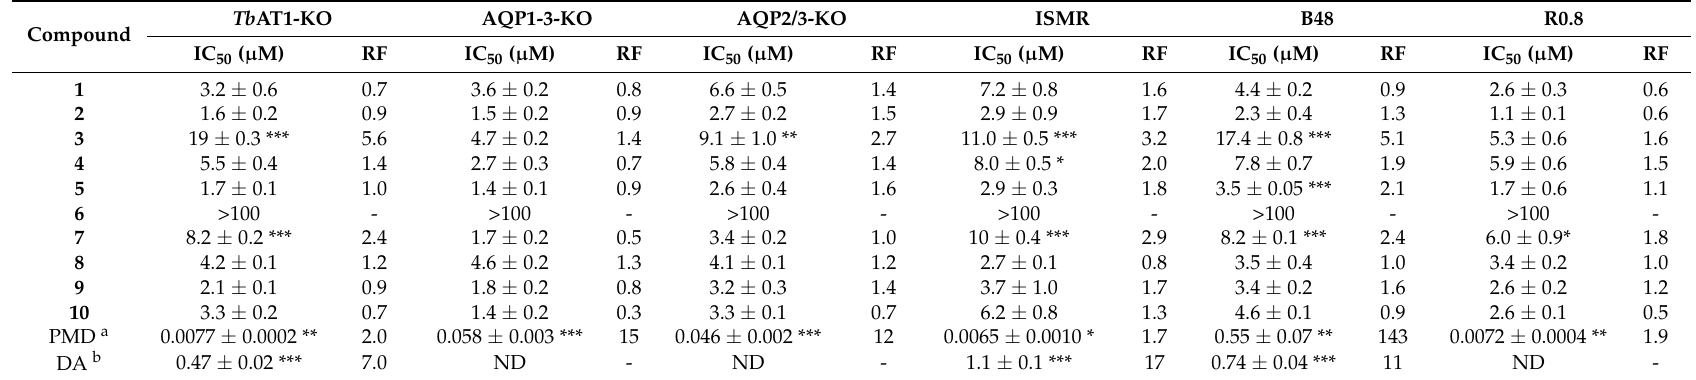
Table 2. In vitro activities and cross resistance profile of selected 3-aminosteroids against some Tbb 427WT-derived resistant cell lines.